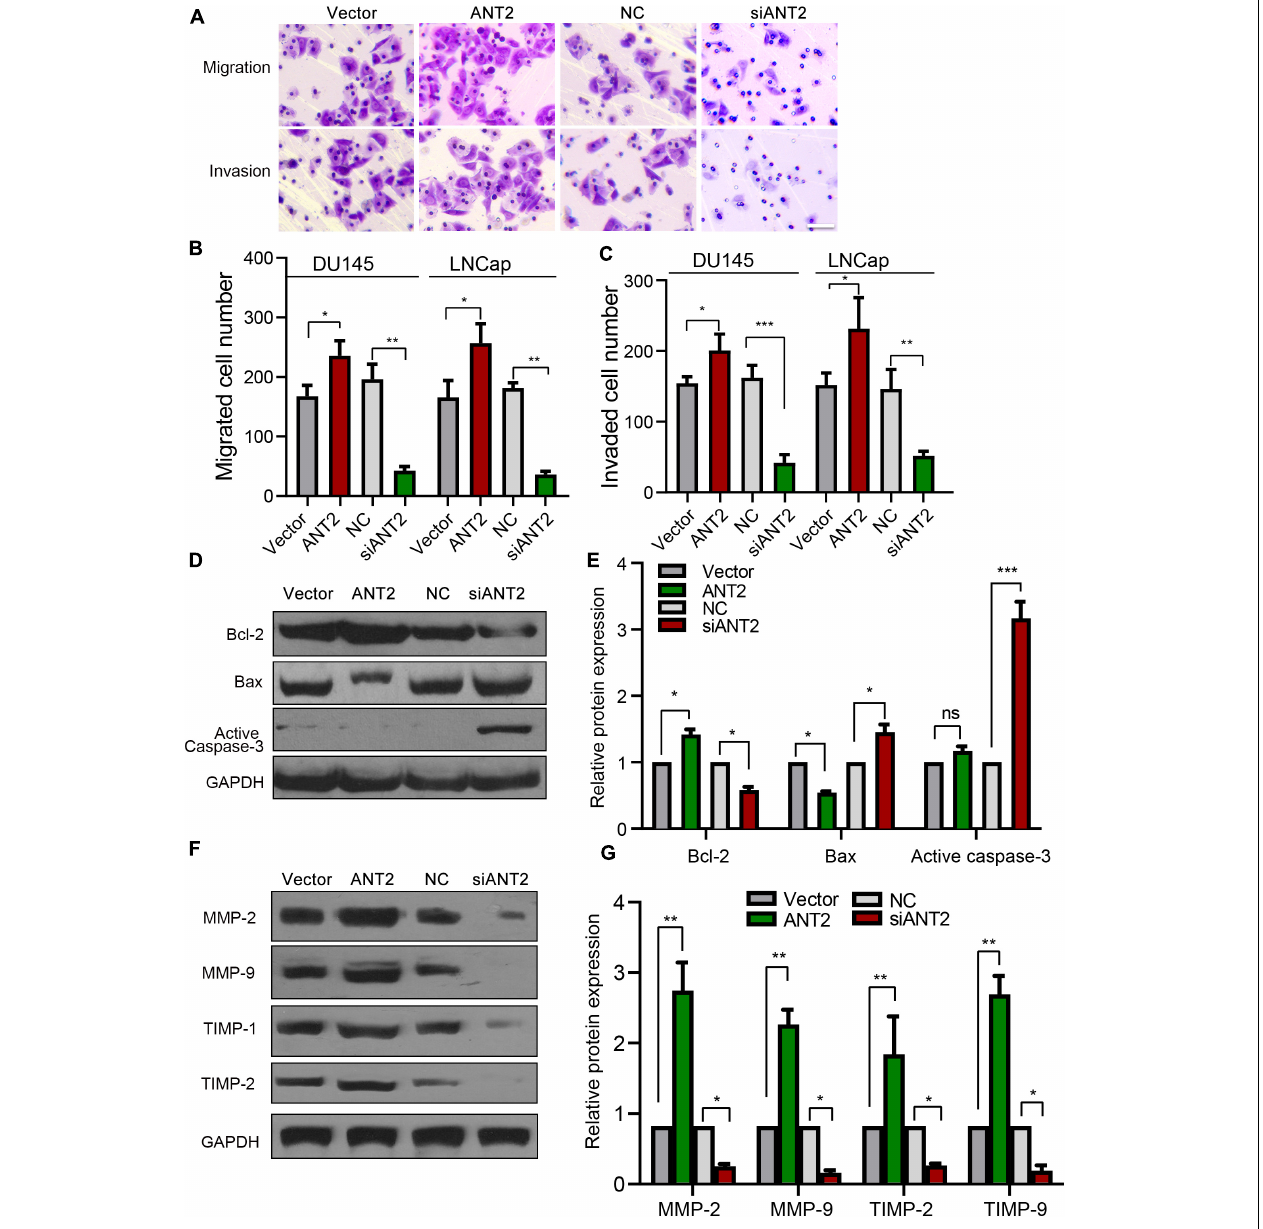
FIGURE 3 | Effects of ANT2 overexpression and silencing on prostate cancer cell migration and invasion. (A) Cell migration and invasion were increased by overexpression of ANT2 and diminished by silencing of ANT2. Scale bar, 20 µ m. (B,C) Overexpression of ANT2 increased migration and invasion by LNCaP and DU145 cells, and silencing of ANT2 decreased migration and invasion. (D,E) ANT2 overexpression caused high expression of Bax, low expression of Bcl-2, and no significant difference in Caspase-3 expression; ANT2 gene silencing caused low expression of Bax, high expression of Bcl-2, and ultra-high expression of Caspase-3. (F,G) ANT2 overexpression caused high expression of MMP-2, MMP-9, TIMP-1, and TIMP-2, while ANT2 silencing caused low expression of MMP-2, MMP-9, TIMP-1, and TIMP-2. * p < 0.05; ** p < 0.01; *** p < 0.001; ns, no significant